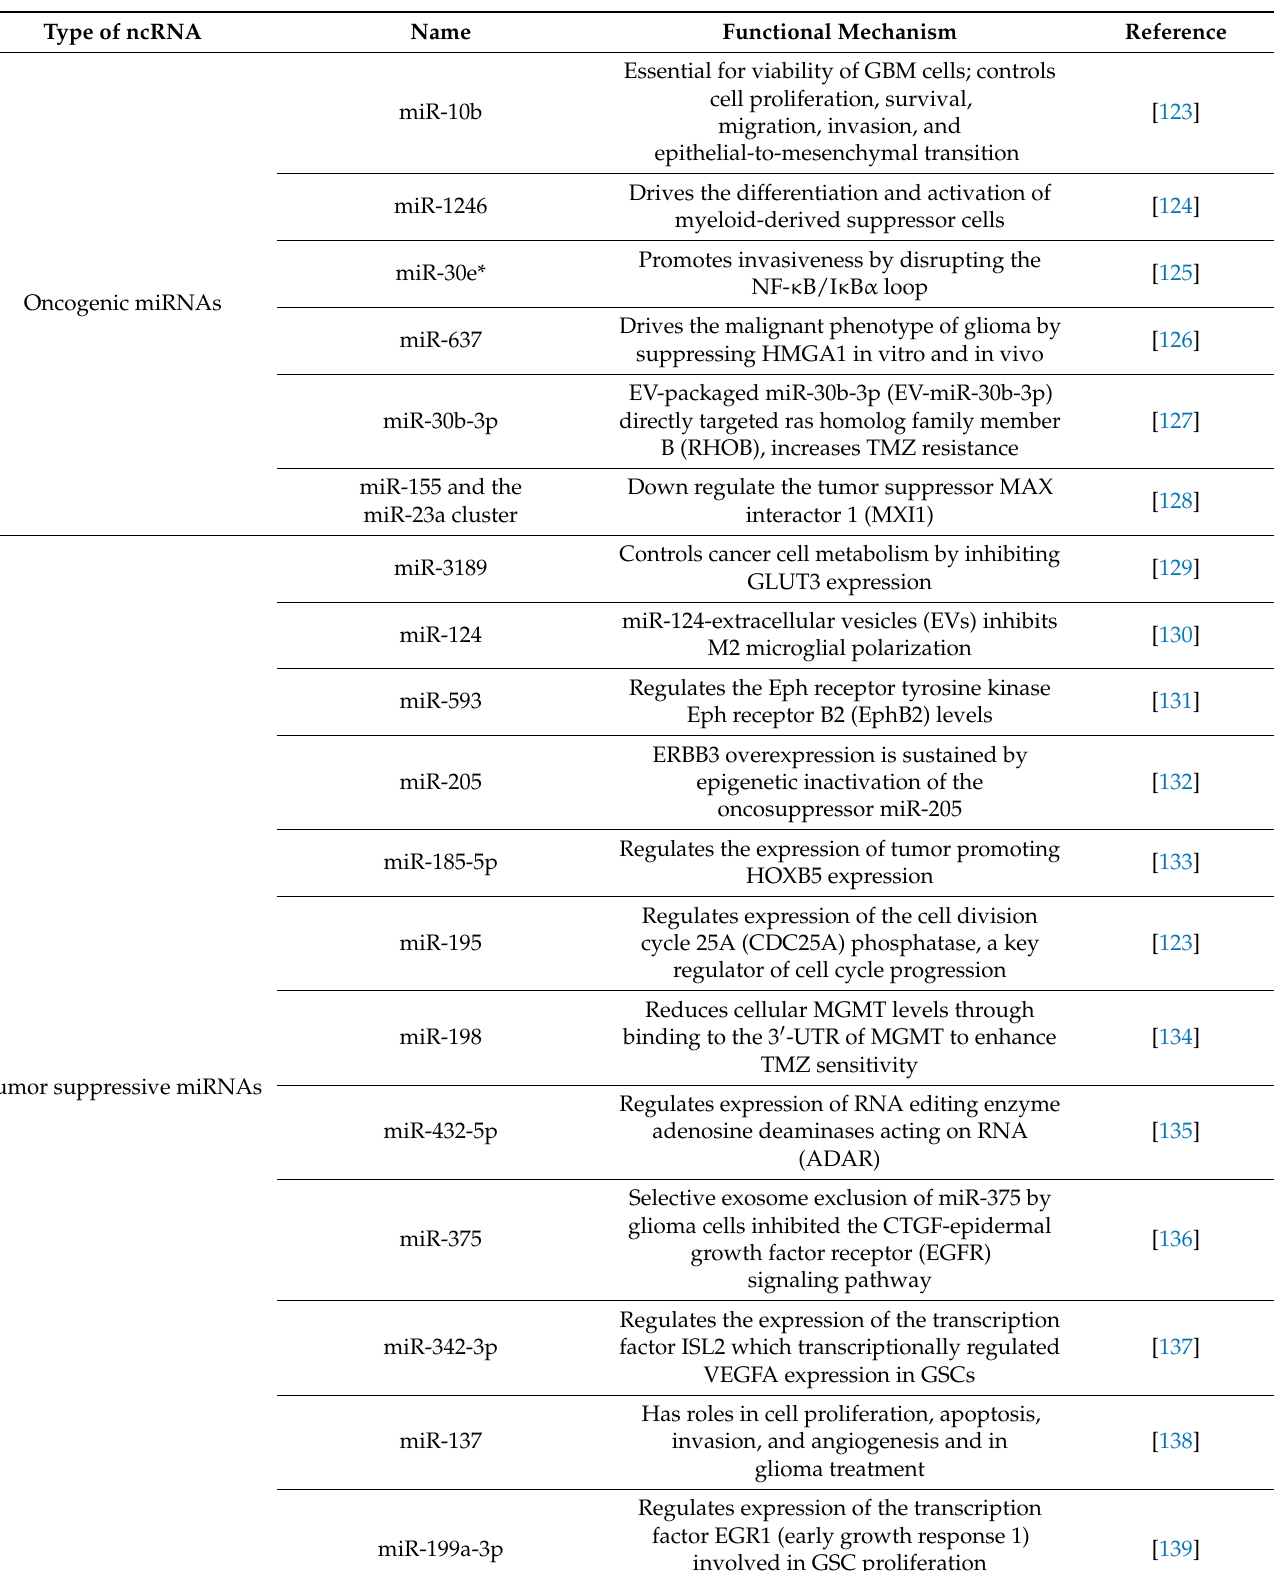
Table 1. Non-coding RNAs associated with